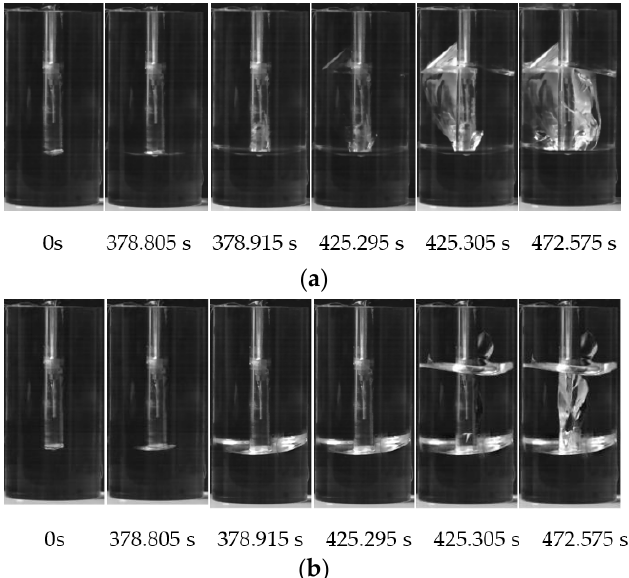
Figure 8. Crack propagation change during the cryogenic thermal shock experiments (sample 1). ( a ) Front; ( b ) sides.